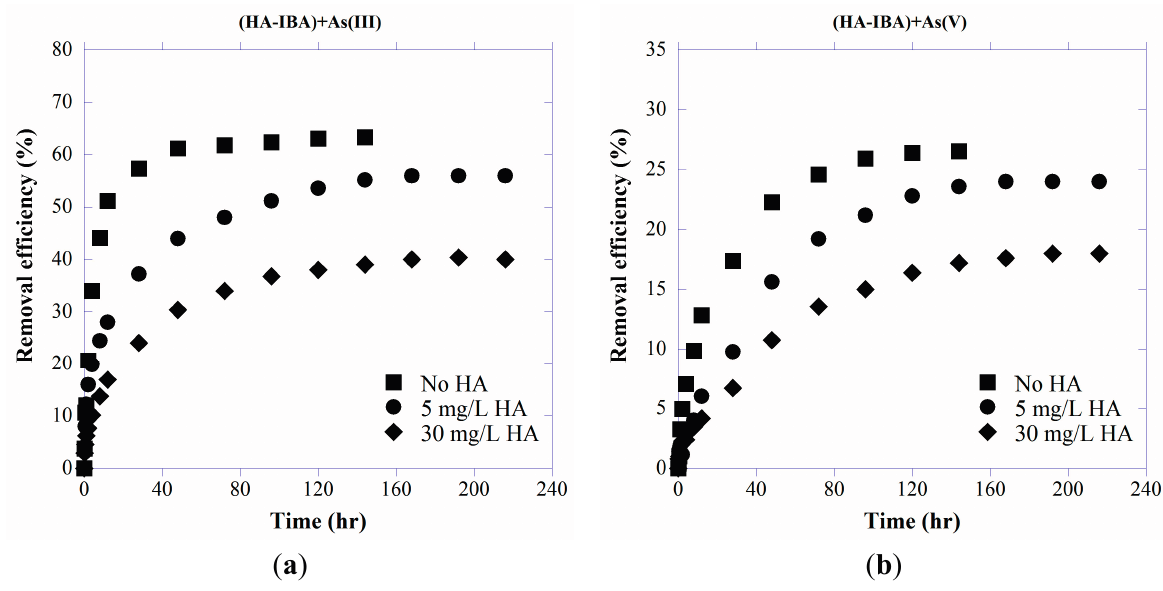
Figure 8. Effect of HA-presorbed IBA on removal efficiency ( a ) As(III) and ( b ) As(V) with initial As concentration of 5 mg/L at pH